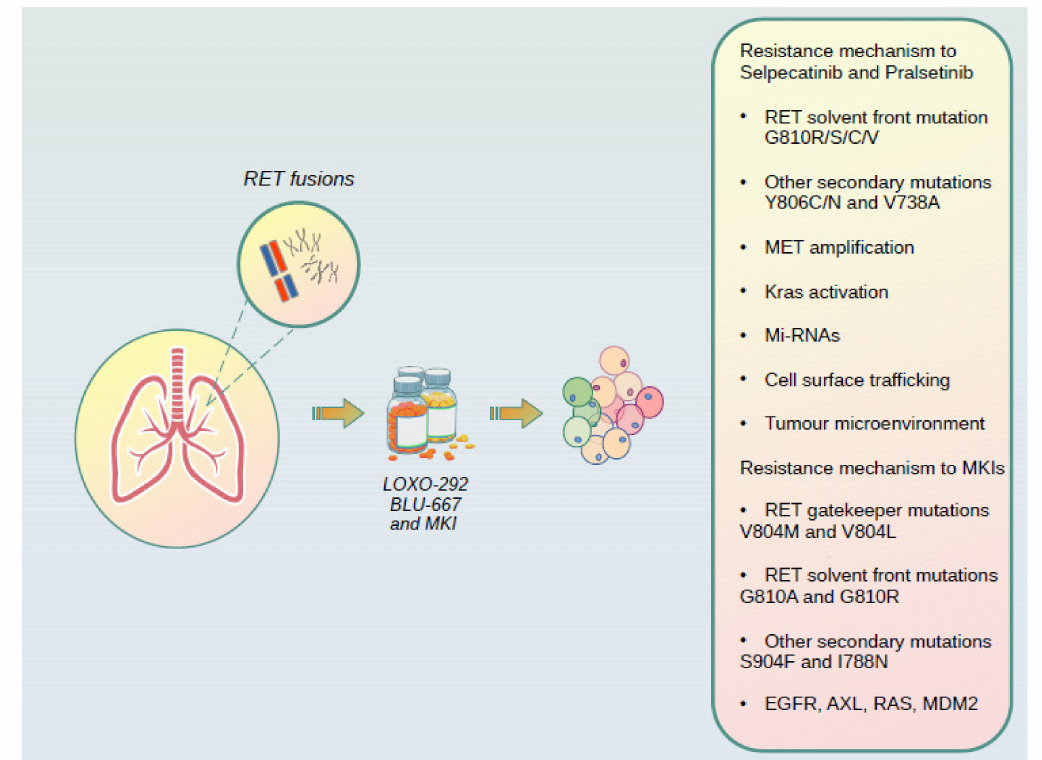
Figure 2. Most common mechanisms of resistance of multikinase inhibitors (MKIs) and new selective RET-inhibitors selpercatinib and